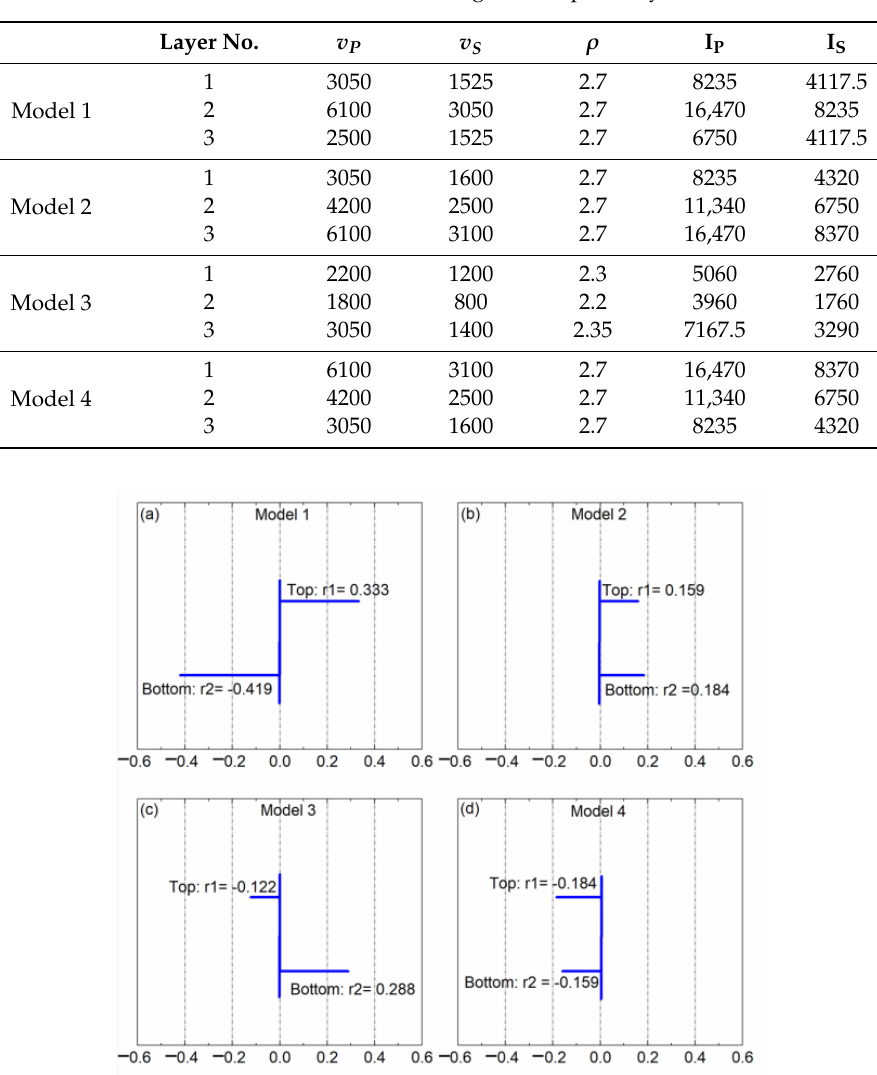
Figure 2. Reflectivity logs of Models 1–4 for normal incidence: ( a ) Model 1, ( b ) Model 2, ( c ) Model 3 and ( d ) Model 4.